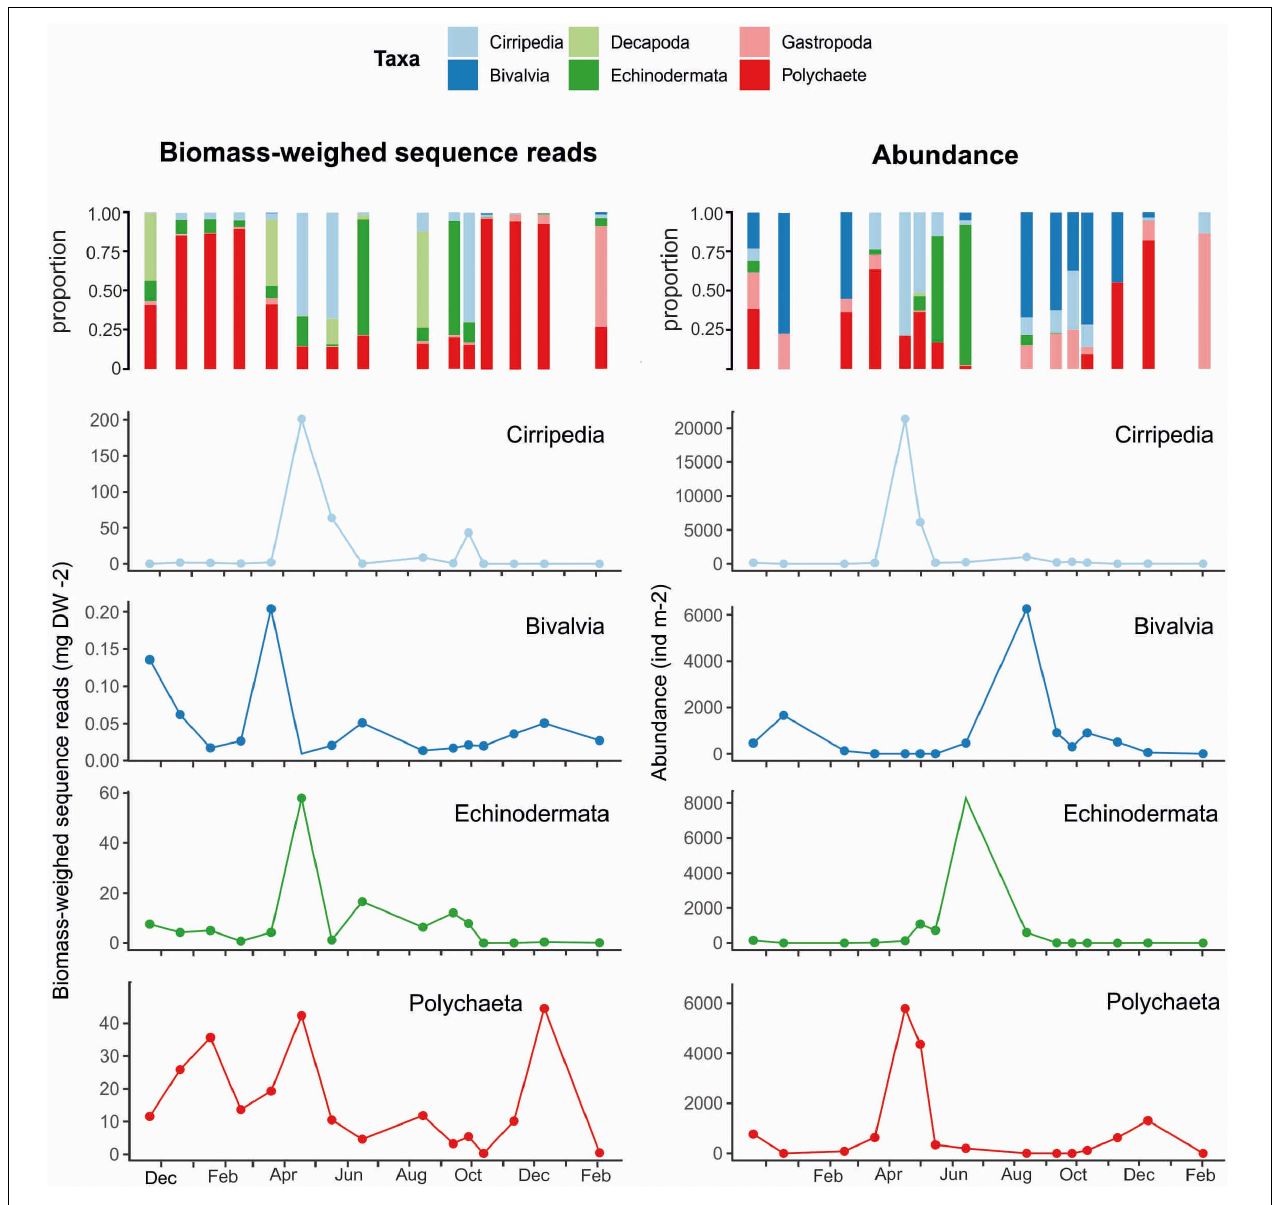
FIGURE 5 | Seasonal changes in the meroplankton BWSR (mg DW m − 2 , left column ) and abundance (individuals m − 2 , right column ) in Ramfjord between November 2018 and February 2020. The first row represents the relative proportions of the main meroplankton groups to the meroplankton community; the remaining rows represent the seasonal variation of the main meroplankton groups.